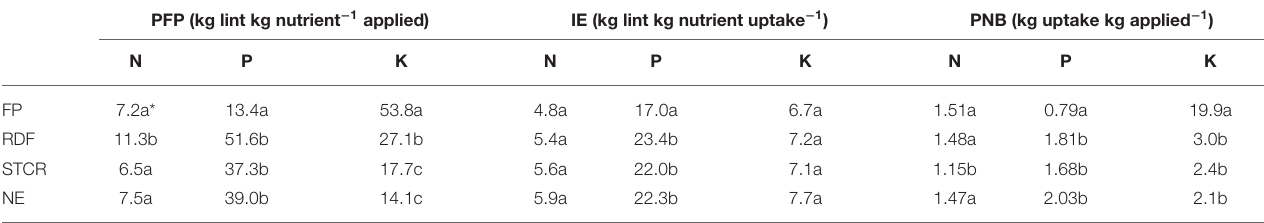
TABLE 3 | Mean partial factor productivity, internal efficiency, and partial nutrient balance as affected by the nutrient management practices. PFP (kg lint kg nutrient − 1 applied)